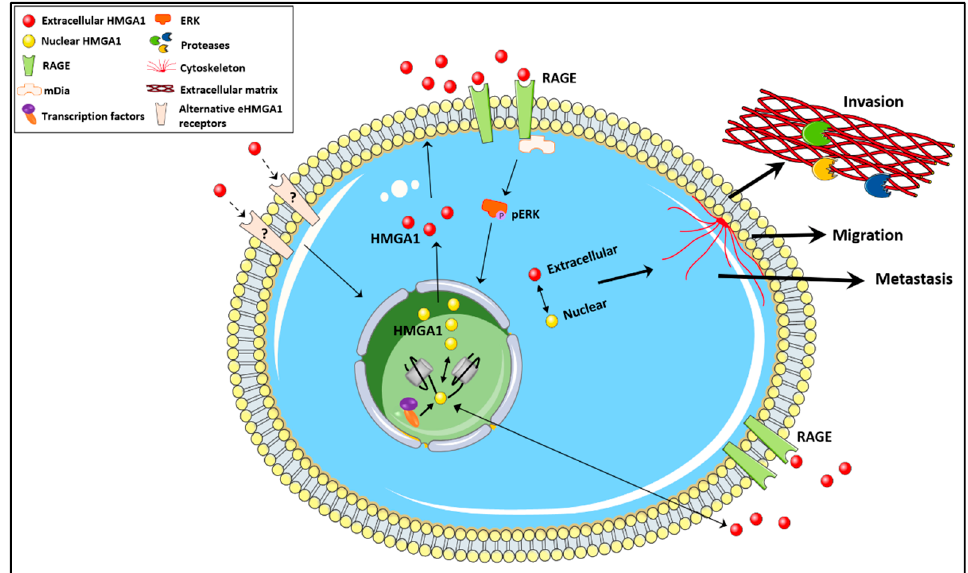
Figure 2. The unconventional secretion of HMGA1 warrants further studies to understand the role of extracellular HMGA1 in cancer biology. Future research should answer questions related to: the molecular mechanism driving the subcellular location of HMGA1, the factors controlling HMGA1 secretion, whether eHMGA1 mediates an oncogenic function by binding to receptors other than RAGE, whether there is a cross-talk between the nuclear and extracellular HMGA1, and how the equilibrium between the two forms of HMGA1 dictates the role of HMGA1 in cancer biology.